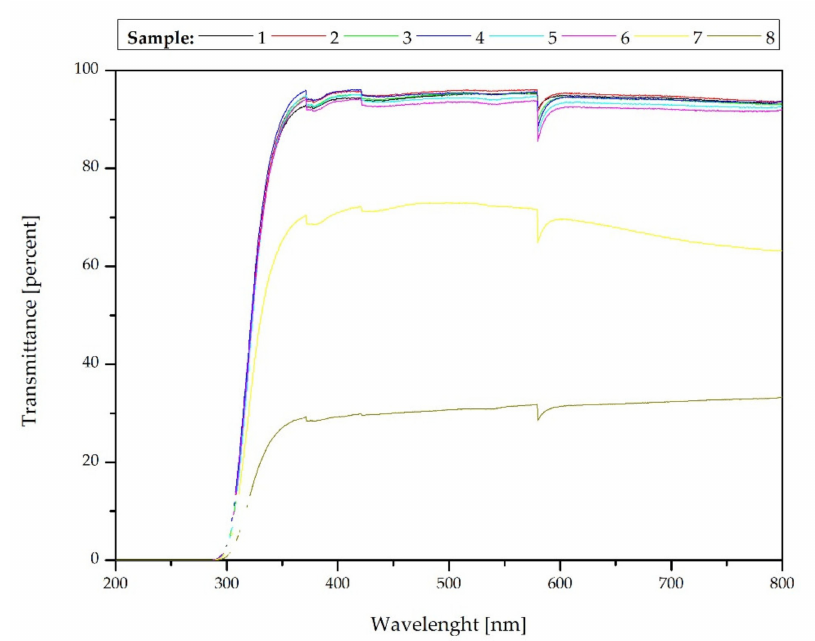
Figure 12. Optical properties—transmittance of the